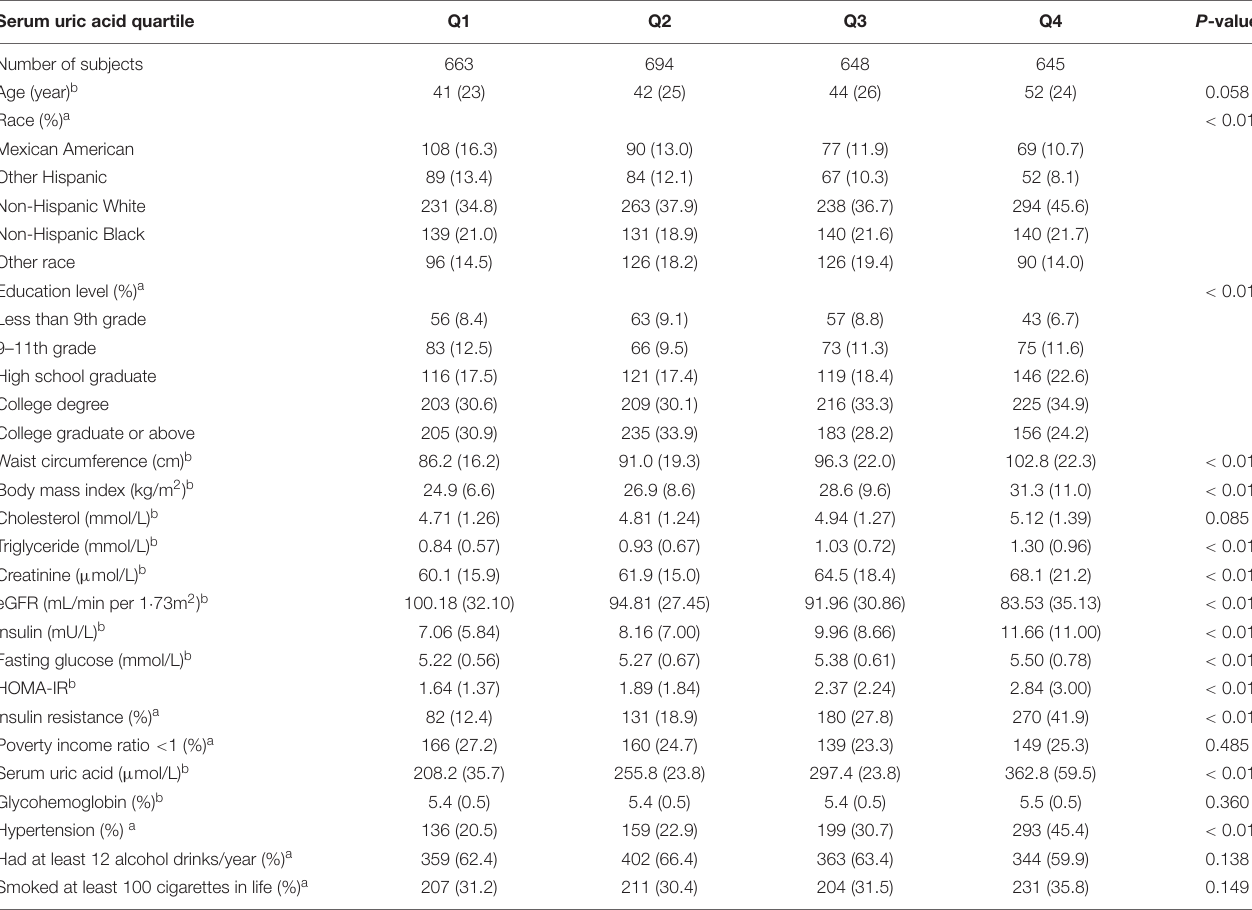
TABLE 2 | Clinical characteristics of the study population disaggregated by quartiles of serum uric acid level. Serum uric acid